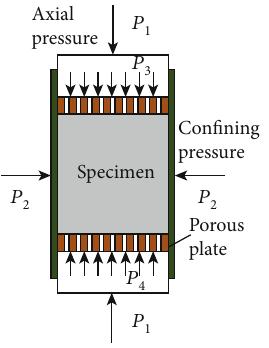
Figure 2: The schematic diagram for testing the seepage characteristics of rock